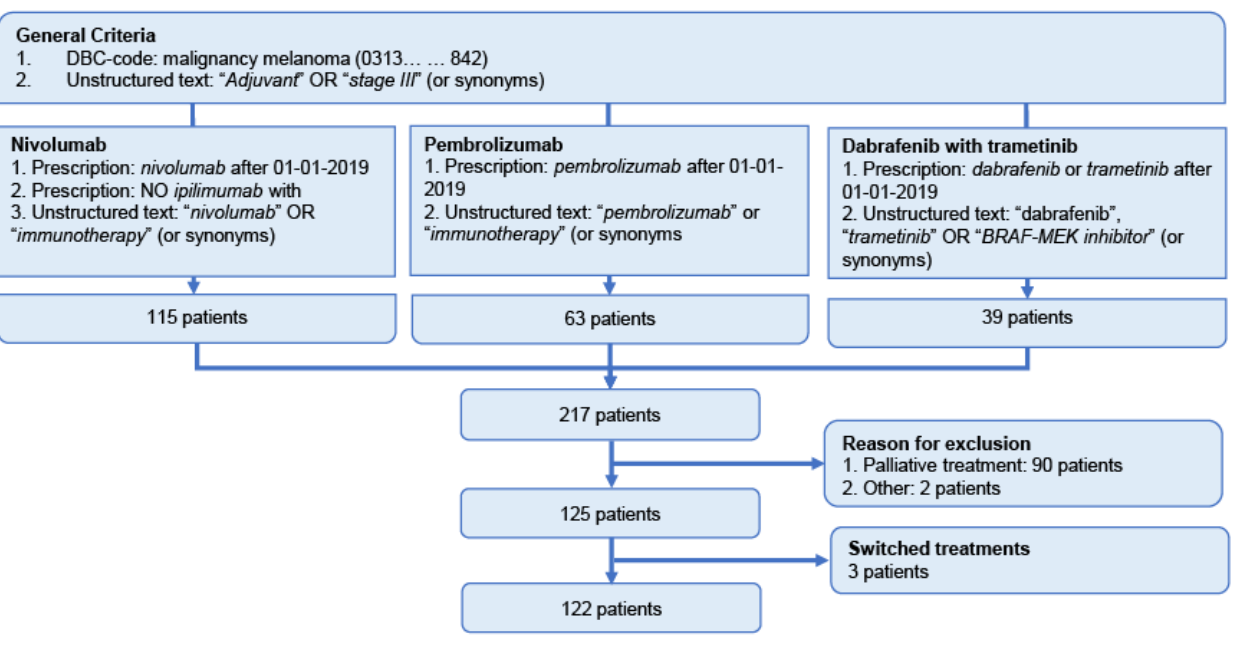
Figure 2. Patient flow chart. DBC ‐ code: diagnosis ‐ treatment combination code.